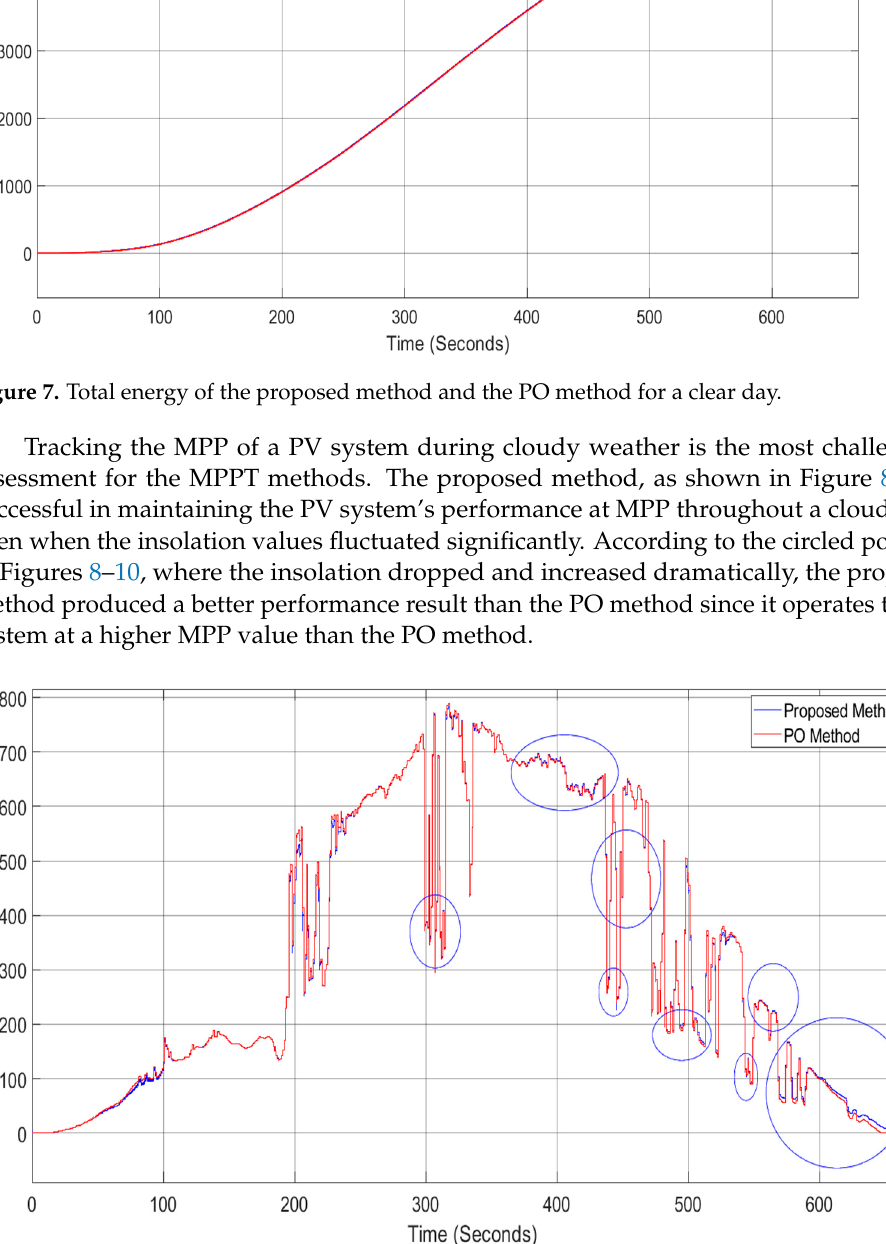
Figure 9. Sample of the output power of the proposed method and the PO method for a period (370 – 430) of time on a cloudy day.